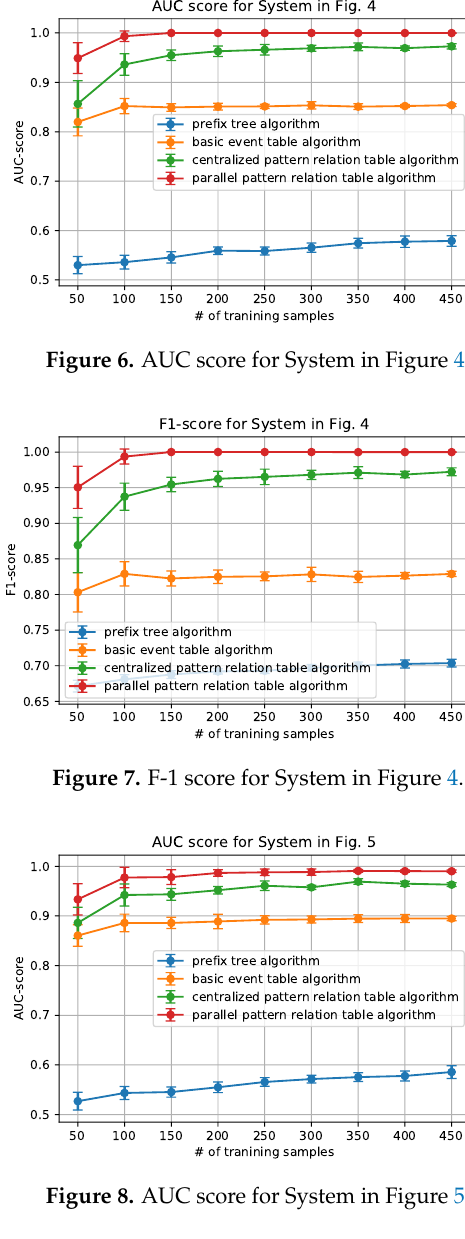
Figure 8. AUC score for System in Figure